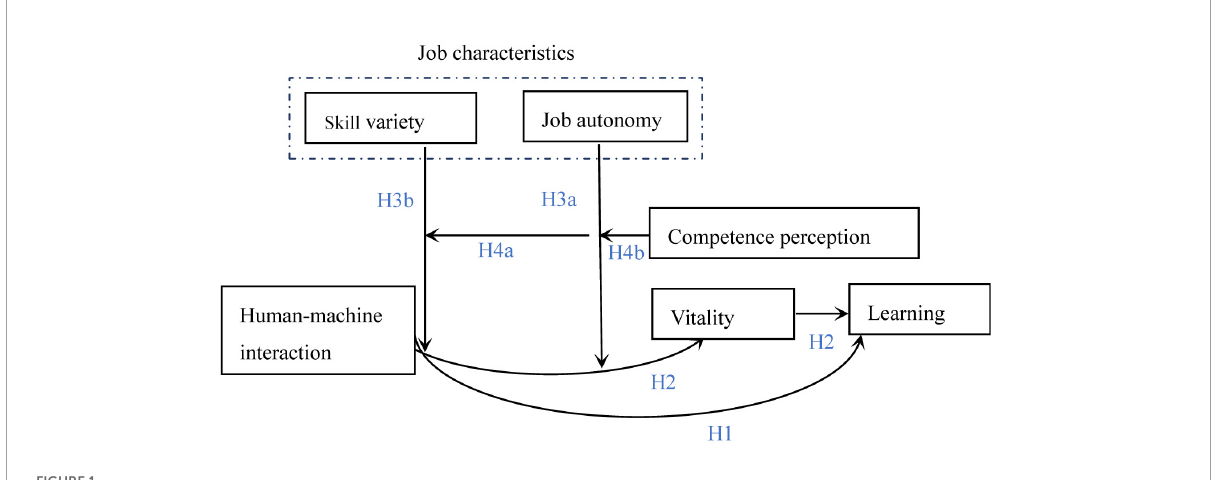
FIGURE1 Conceptual